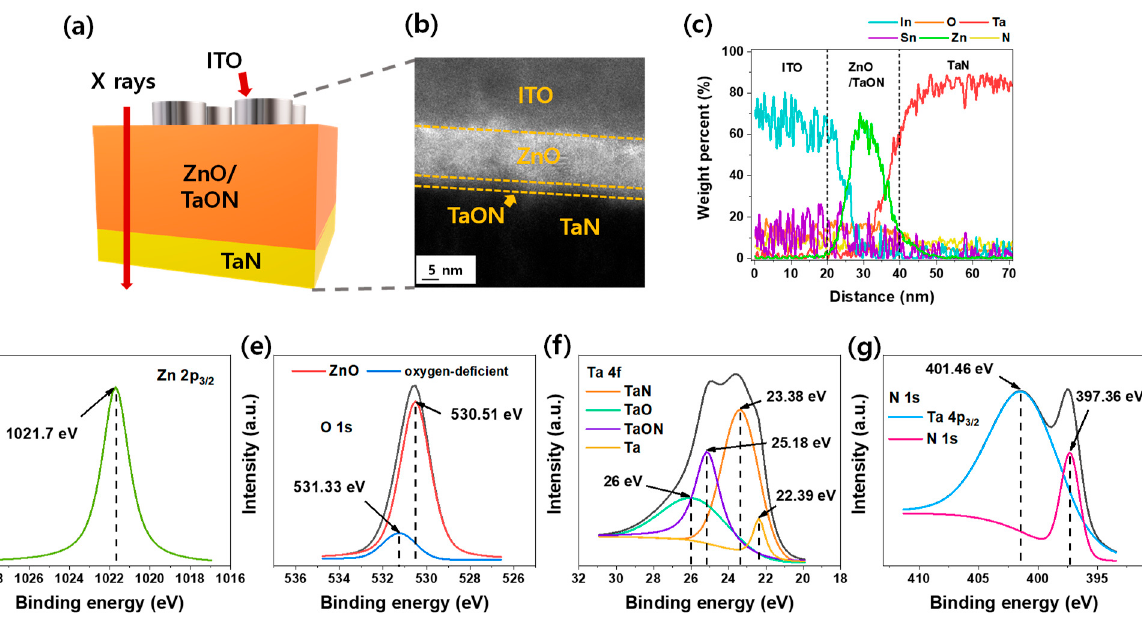
Figure 1. ( a ) Schematic of structure and components of ITO/ZnO/TaON/TaN device. ( b ) TEM image and ( c ) EDS weight percent. XPS spectra of ( d ) Zn 2p3/2, ( e ) O 1s, ( f ) Ta 4f, and ( g ) N 1s scan ZnO/TaON/TaN without TE.